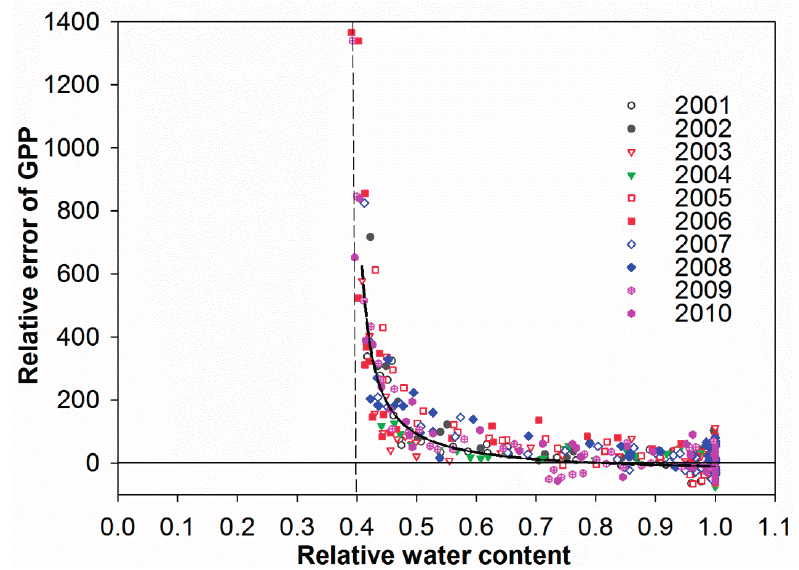
Figure 4. Nonlinear regression between the relative soil water content and the weekly relative error of GPP between MODIS estimates and measurements at the tower